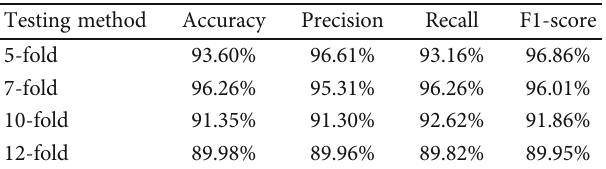
Table 2: Crossvalidation testing for k = 5 , 7, 10, and 12-folds to determine the best performance k -validation